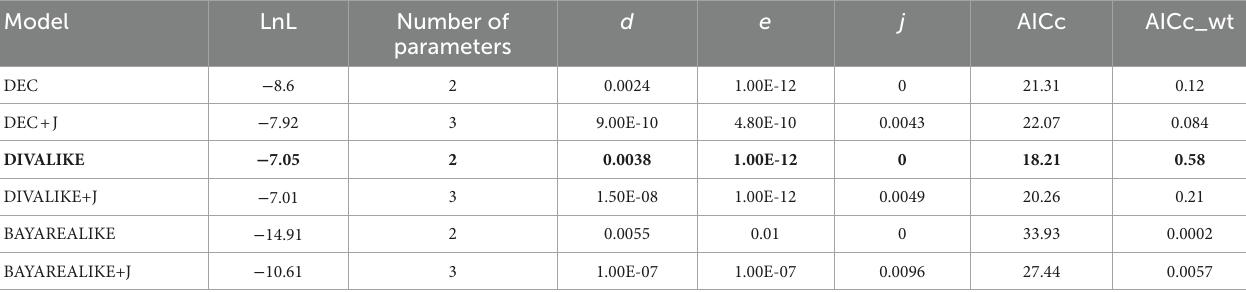
Comparison of the fit of different models of geographic-range evolution and model-specific estimates for the different parameters. LnL referred to log-likelihood; d , rate of dispersal; e , rate of extinction; j , the likelihood of founder-event speciation at cladogenesis; AICc, the corrected Akaike information criterion. The AIC model weight is used to compare all the models together to select the best one. The preferred model is indicated by the bold and red